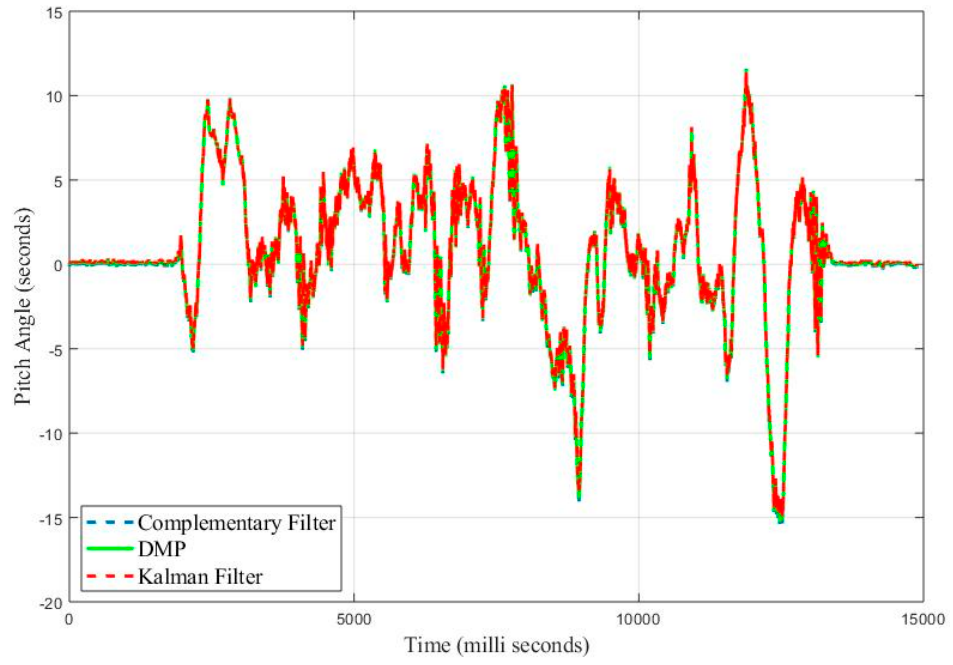
Figure 32. Real Time Pitch Angle Estimate for Complementary and Kalman Filter.